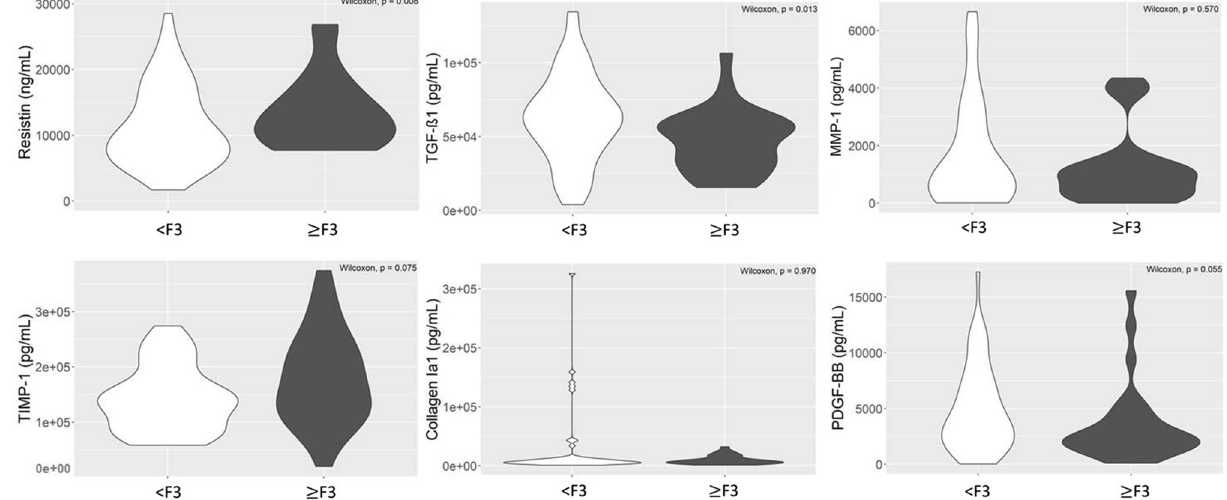
Figure 1. Distribution of fibrosis markers (resistin, TGF-β1, MMP-1, TIMP-1, collagen IA1 and PDGF-BB) according to fibrosis stage (< F3; ≥ F3). A p value lower than 0.05 was considered statistically